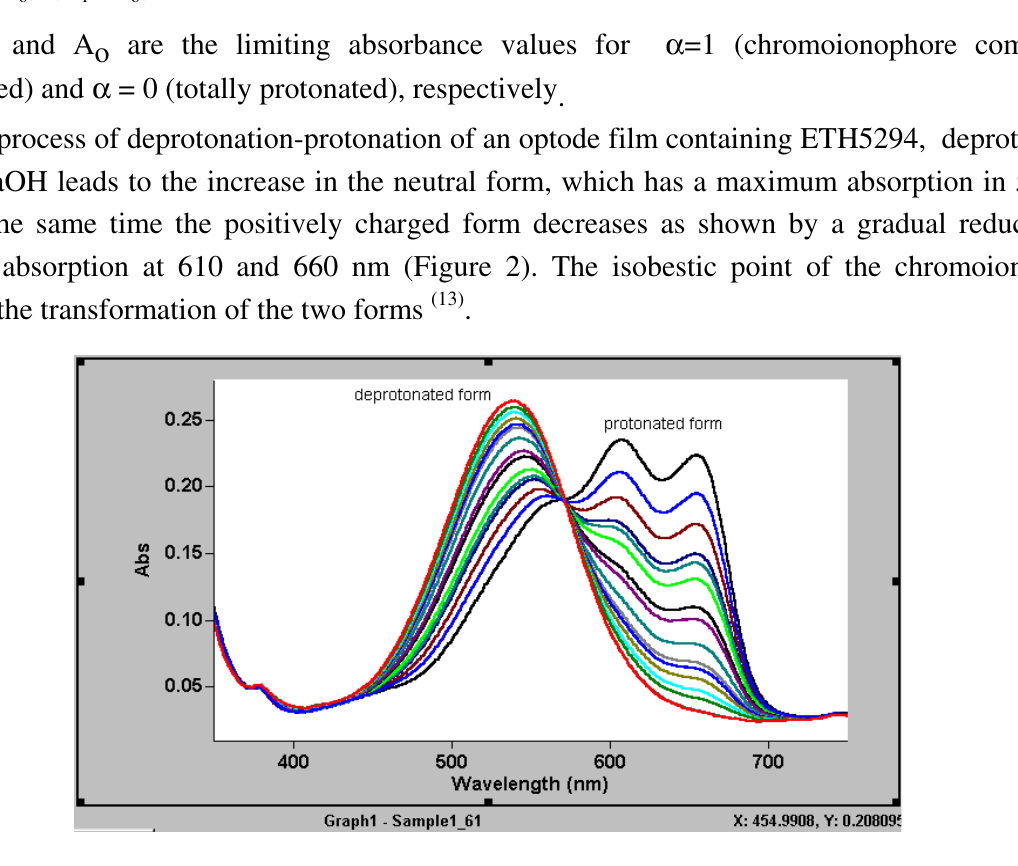
Figure 2. The absorption behaviour of a MB28 optode film containing chromoionophore ETH5294 and NaTFPB in 6M of NaOH showing conversion of the initial fully protonated form to the completely deprotonated form.